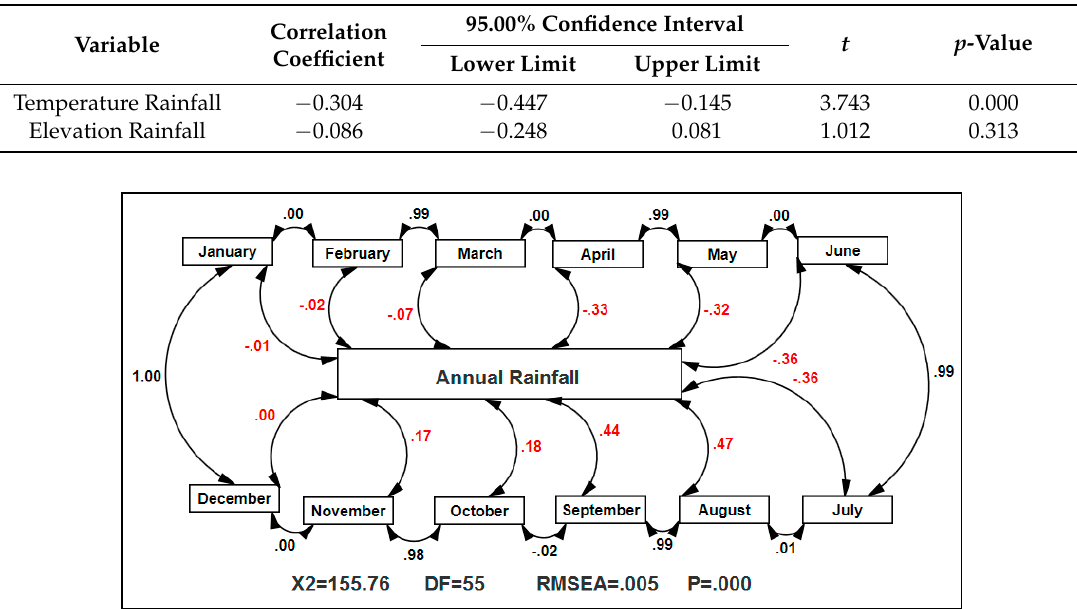
Figure 7. The temporal correlation analysis between the monthly temperatures and annual rainfall.